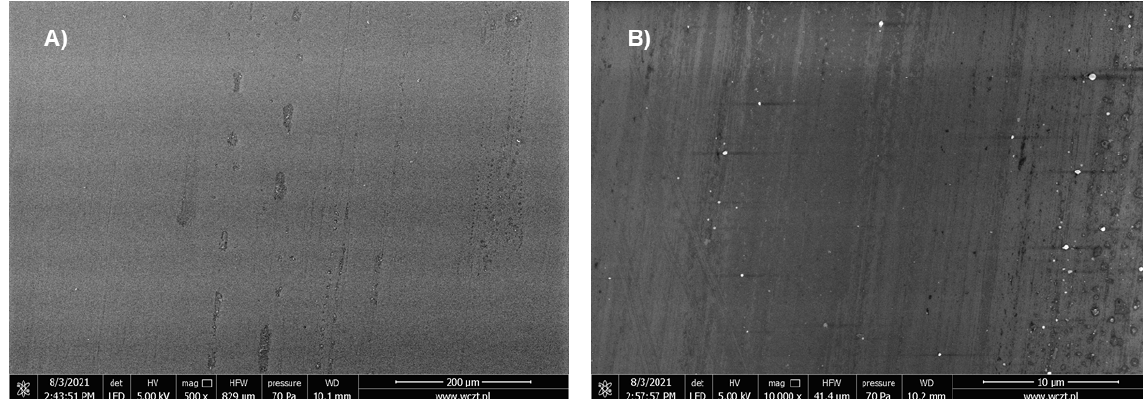
Figure 5. SEM image of the thin film of polymer poly-1 with magnification 500× ( A ) and 10,000× ( B ). The film thickness was investigated using AFM scratch method. To do this, the pol- ymeric film was cutted with the blade and the difference between the polymeric film and bare ITO surface was measured in few different places by AFM (Figure 6).